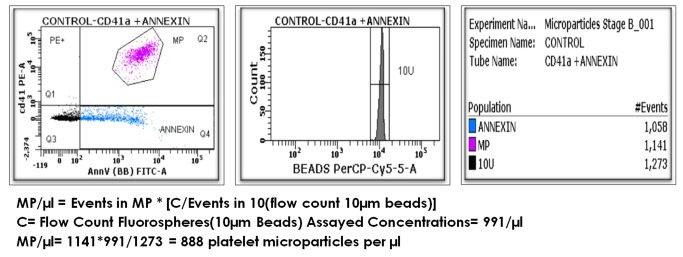
Microparticle(MP) analysis in patients.1st graph shows dual-positive MPs expressing both FITC- PS and the PE- cell specific marker in quadrant 2 (Q2) and shows MPs expressing only FITC- PS in quadrant 4 (Q4). The total no. of MPs is calculated using the formula: MP/µl = Events in MP * [C/Bead Events (flow count beads)] C= Flow Count Fluorospheres Assayed Concentrations provided by the manufacturer.